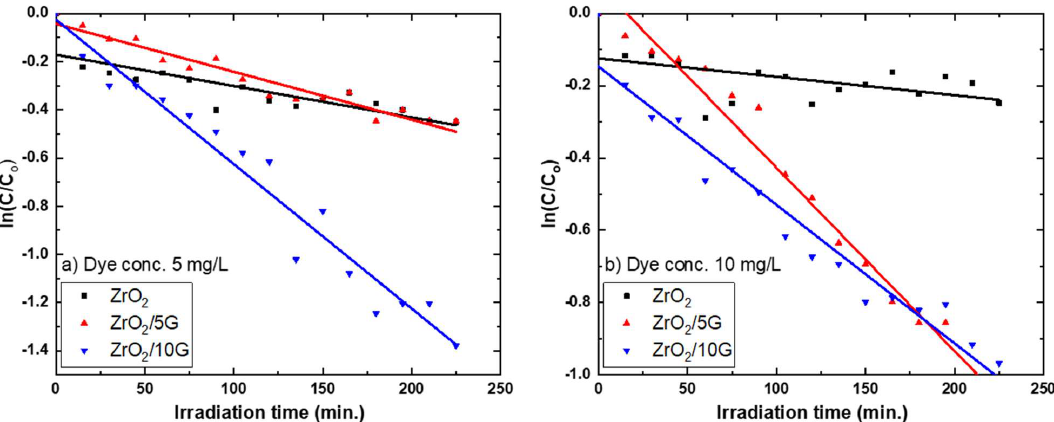
Table 4. First-order reaction rate constants ( k ) and the degradation equilibrium constant ( K ), and experimental q e values for the 10 mg/L MB degradation on ZrO 2 , ZrO 2 /5G, and ZrO 2 /10G at 303 K. MB 10 mg/L